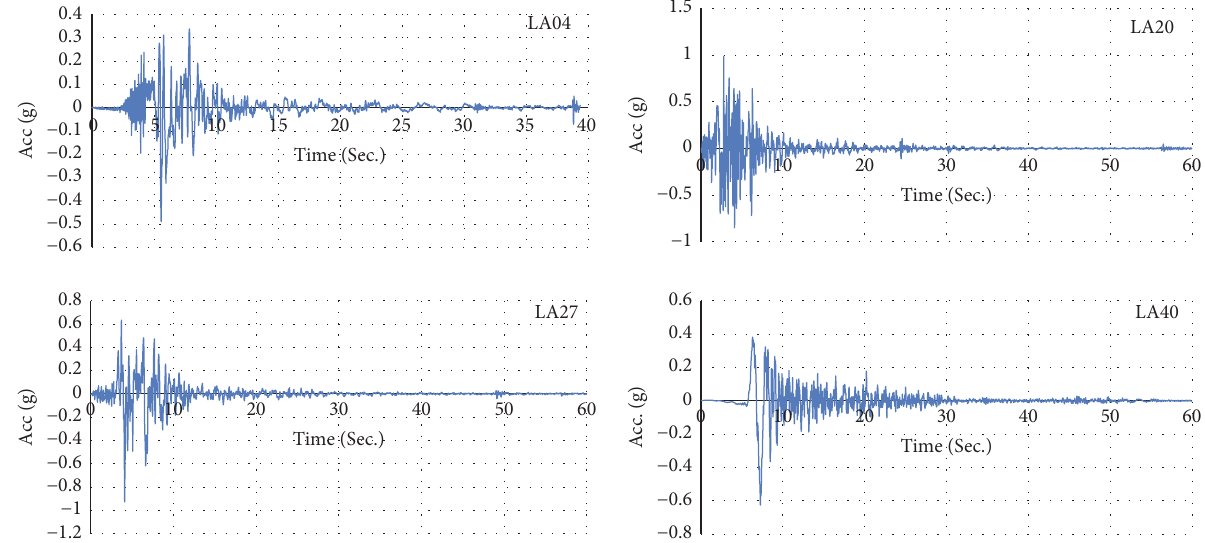
Figure 2: GMs’ recorded signals for the training and testing stages.